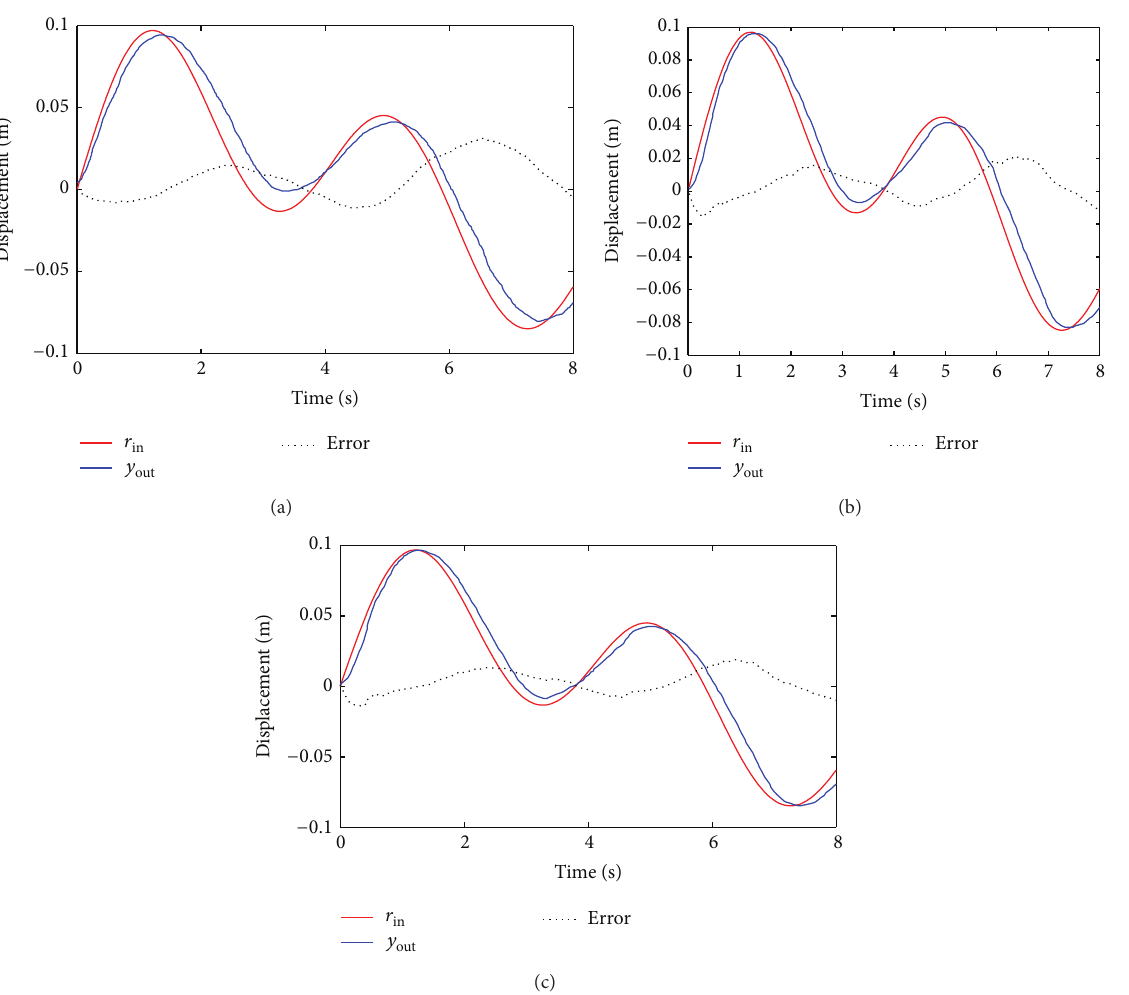
Figure 11: Experimental results for VCAHC of random signal under fixed load: (a) PID controller, (b) CMAC-PID controller, and (c) CMAC- PI 𝜆 D 𝜇